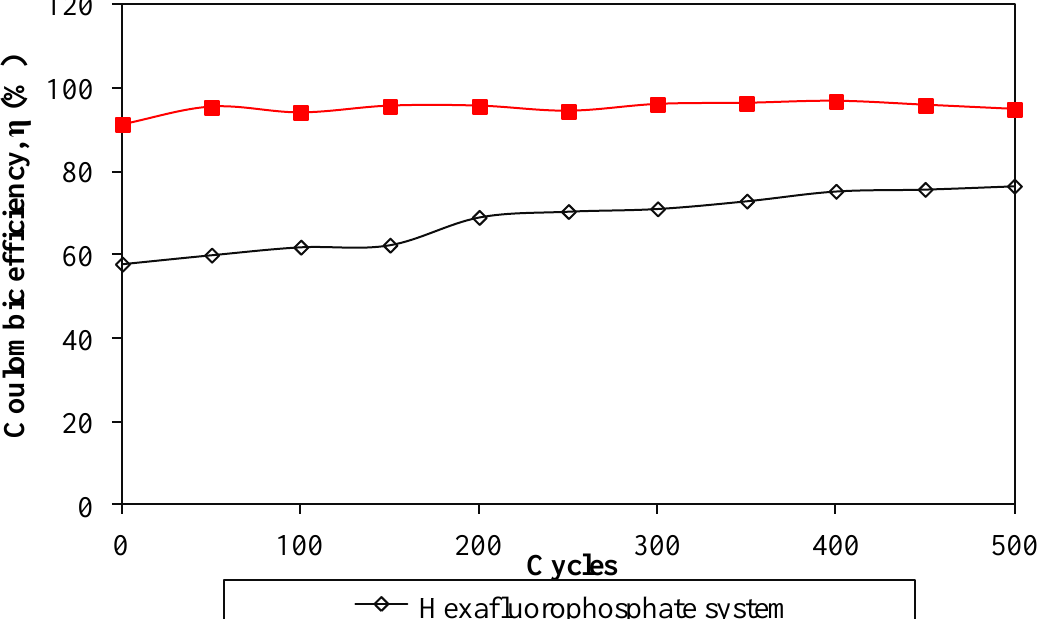
Figure 9. Coulombic efficiency of different ionic liquid-based biopolymer electrolyte systems over 500